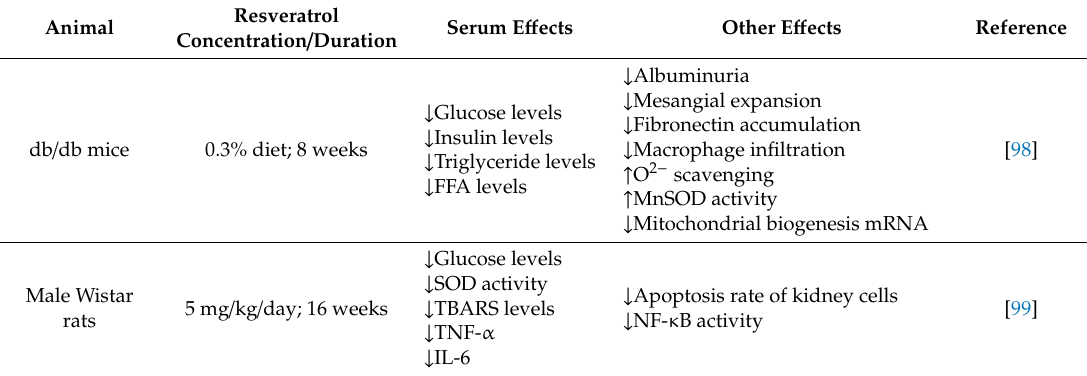
Table 7. E ff ects of resveratrol on diabetic nephropathy (animal